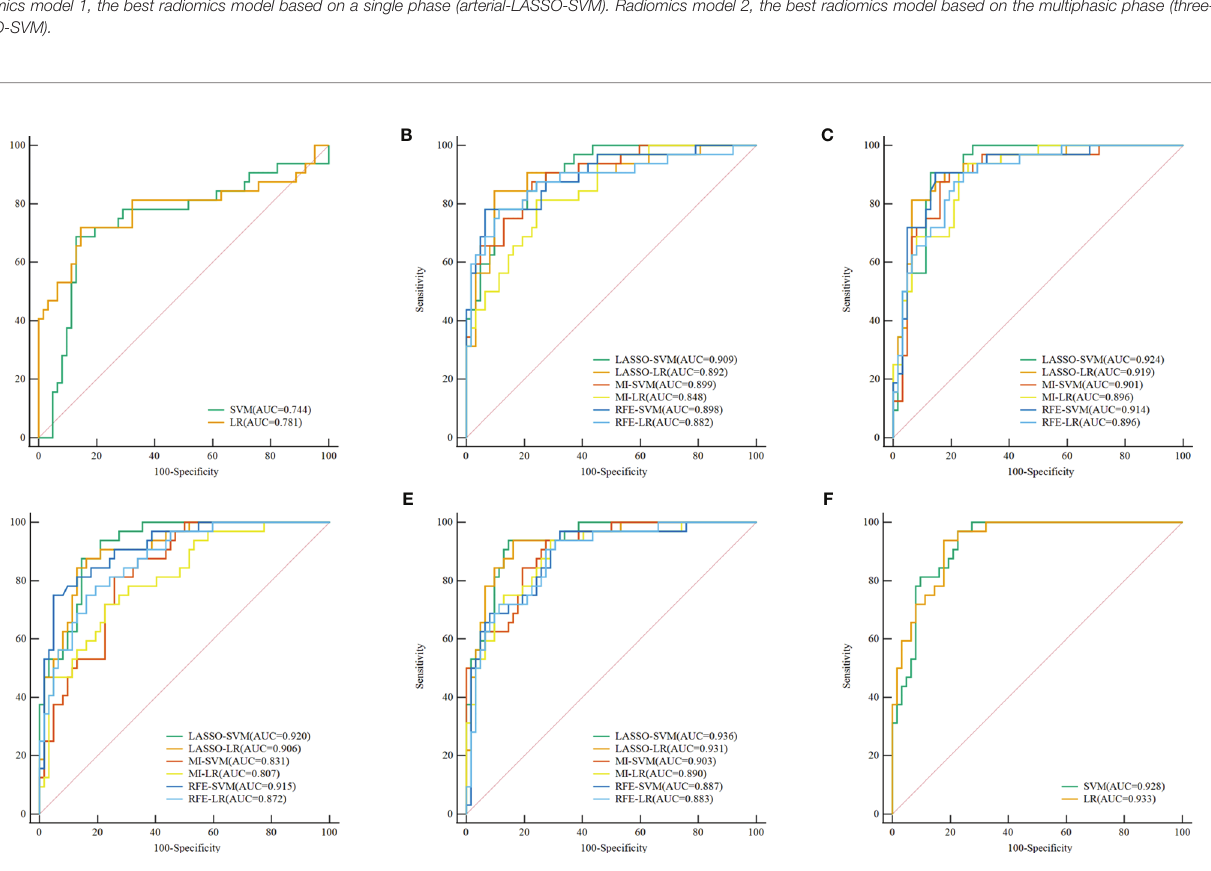
FIGURE 3 | ROC curve of the clinical, radiomics, and combined models in the test set, respectively. (A) ROC curve of Clinical models. (B – E) ROC curve of radiomics models (different combinations of 3 feature selection methods and 2 classi fi ers) based on the plain scan, arterial phase, venous phase, and three-phase combination. (F) ROC curve of combined models. ROC, receiver operating characteristic; LASSO, least absolute shrinkage and selection operator; MI, mutual information; RFE, recursive feature elimination; SVM, support vector machine; LR, logistic